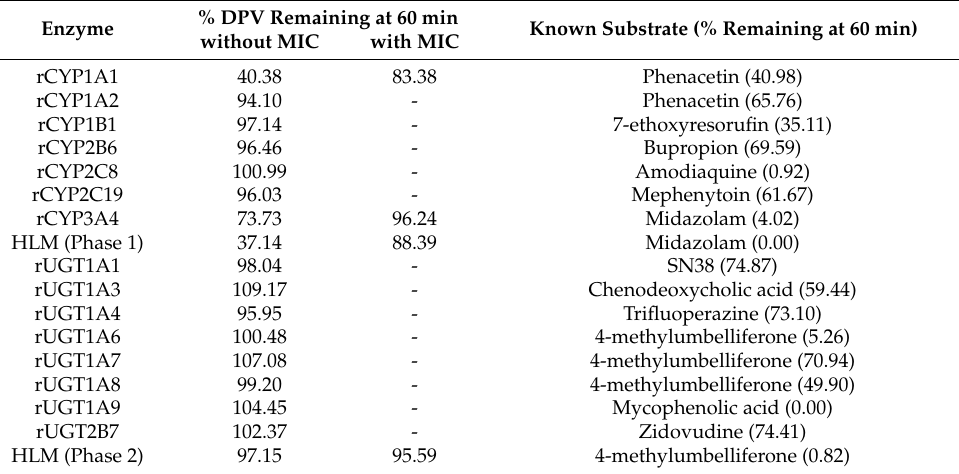
Table 1. The % remaining of DPV (without and with MIC) and probe substrates at 60 min in different recombinant CYP and UGT enzymes and HLM (phase 1 and 2 enzymes). Data are represented as the mean of two biological